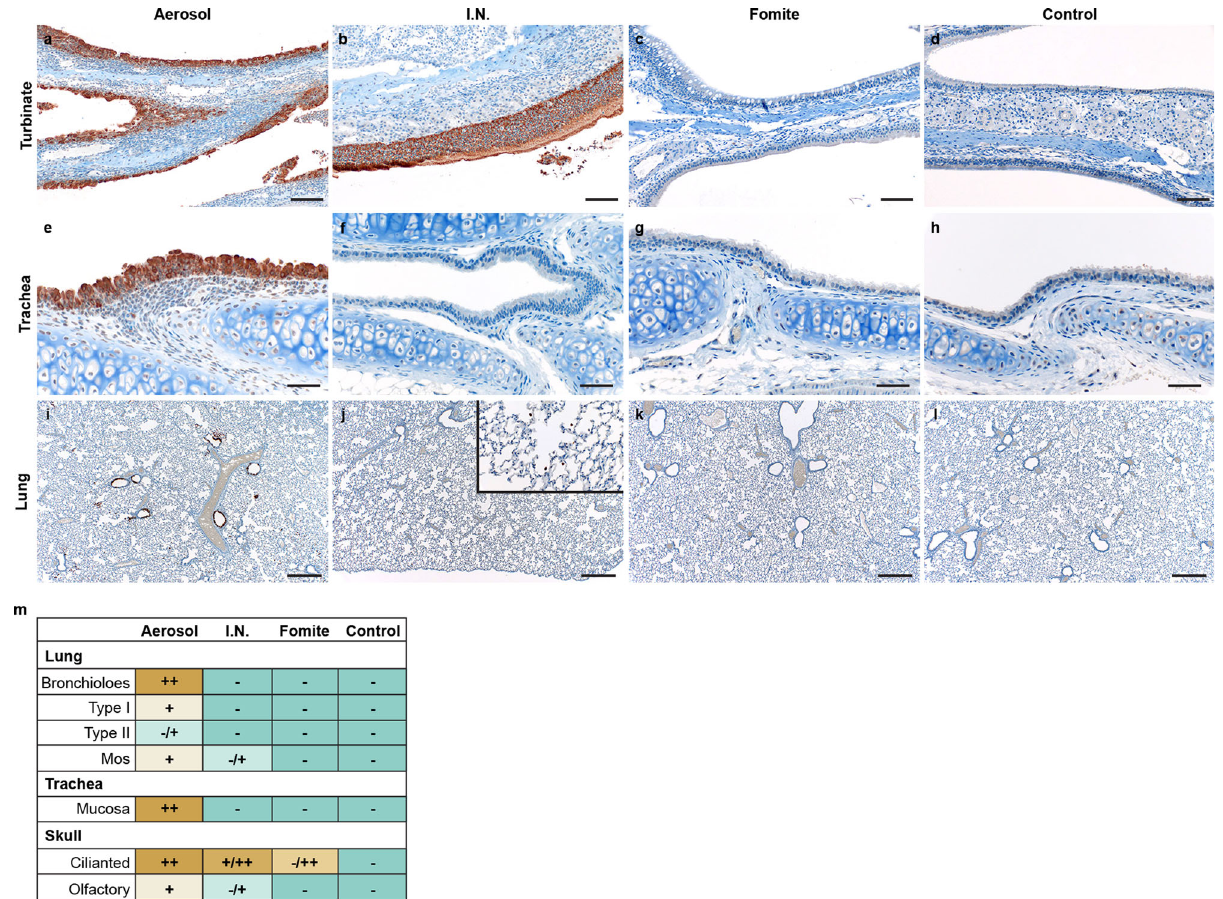
Fig. 2 Comparison of early replication of SARS-CoV-2 in respiratory tract. Comparison of replication of SARS-CoV-2 for intranasal (I.N.), aerosol and fomite inoculated hamsters at 1 day post inoculation (DPI) by immunohistochemistry ( N = 4). a – c SARS-CoV-2 antigen detection in ciliated epithelial cells of the nasal mucosa (200x; bar = 100 µ m). d Nasal mucosa from a control hamster (200x; bar = 100 µ m). e – g SARS-CoV-2 antigen detection throughout tracheal ciliated epithelial cells (400x; bar = 50 µ m). h Normal tracheal mucosa from a control hamster. i SARS-CoV-2 antigen detection focused on terminal bronchioles and adjacent alveolar spaces (40x; bar = 500 µ m). j Lack of SARS-CoV-2 in epithelial cells with strong antigen detection noted in pulmonary macrophages (inset) (40x; bar = 500 µ m). k Lack of SARS-CoV-2 antigen detection throughout the lung (40x; bar = 500 µ m). l Normal lung from control hamster (40x; bar = 500 µ m). m Quantitative comparison of antigen detection for lung (type I and type II pneumocytes, macrophages (mos), mucosa of the trachea and skull sections (olfactory and ciliated epithelium of the nasal turbinates) at 1 day post inoculation for I.N., aerosol, fomite, and control